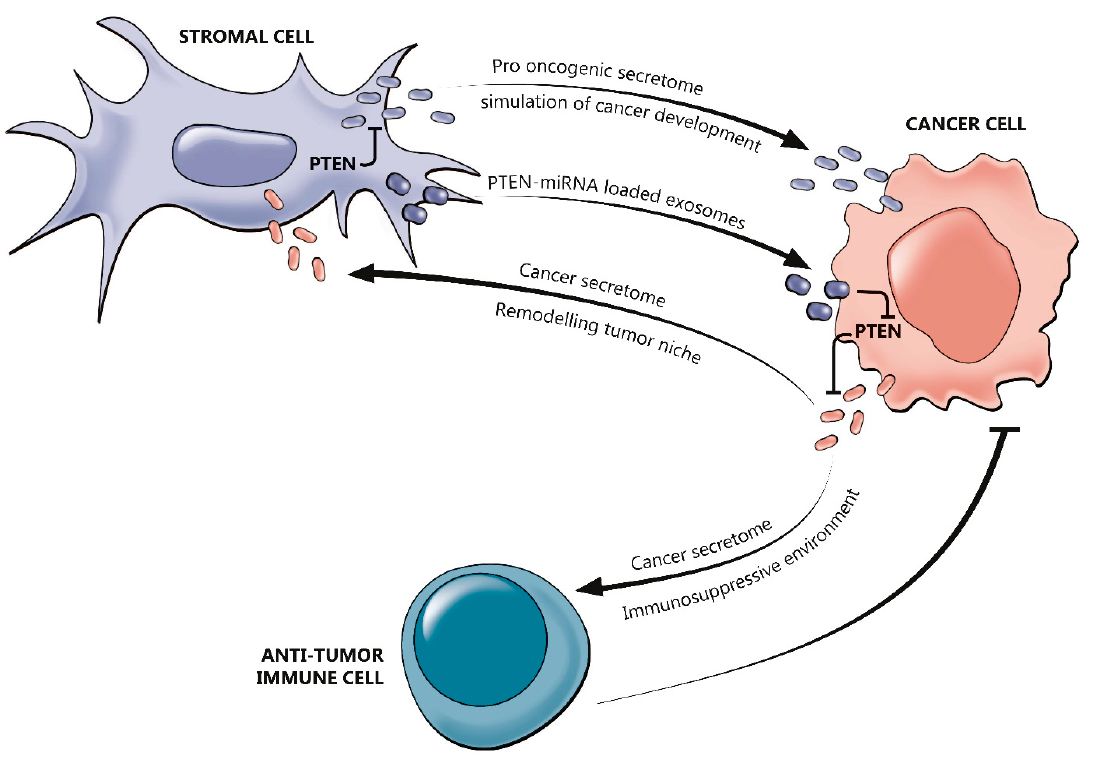
Figure 4. Role of PTEN in the regulation of the tumor immune microenvironment. PTEN in tumor cells may regulate the cancer cell secretome to prevent the secretion of immunosuppressive chemokines and, consequently, favoring the establishment of an immune-permissive tumor microenvironment, which would improve antitumor immune responses. PTEN may also prevent the formation of reactive